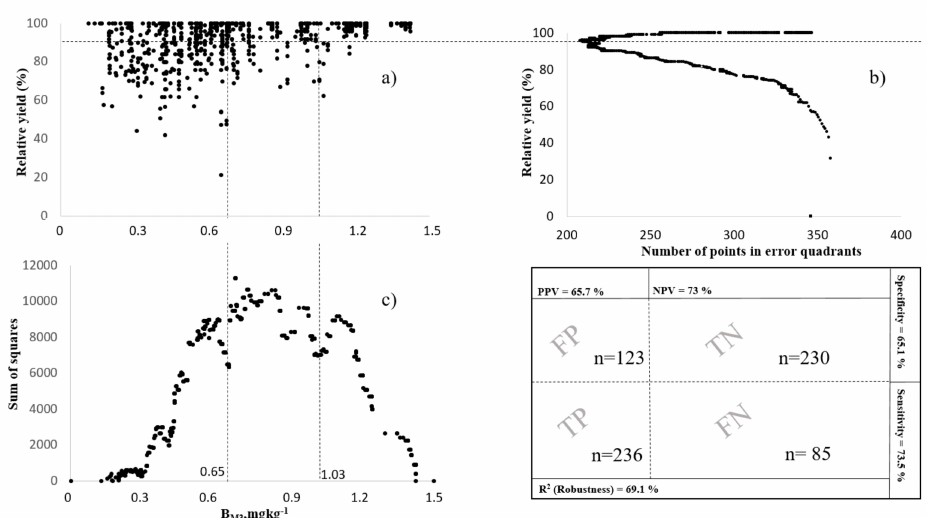
Figure 5. Construction of the diagnostic and statistical model of Cate–Nelson classification for boron Mehlich-3 showing the ( a ) Cate–Nelson graph for the critical thresholds identified; ( b ) number of points outside the model for the determination of the critical relative yield ( RY ); ( c ) sum of squares for determination of the critical B M3 ; and and summary table (lower right) n : Number of points in the di ff erent quadrants; Performance indicators of the partition model. R 2 , accuracy; NPV, negative predictive value; PPV, positive predictive